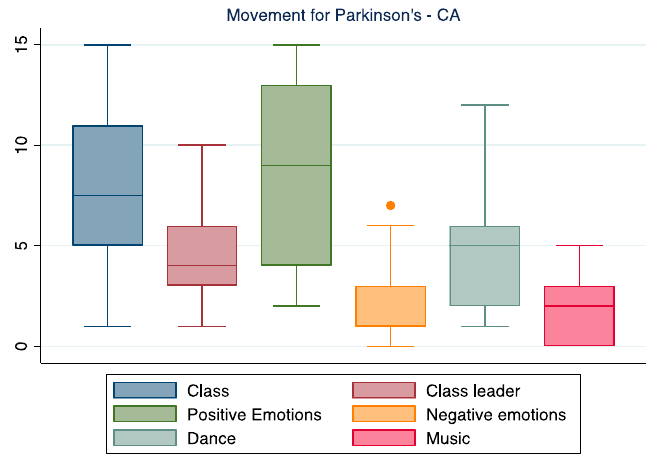
Figure 5. The focus on Movement for Parkinson’s. In the boxplot, the central horizontal line indicates the median, the other two lines indicate the first (lower line) and third (higher line) quartiles, the whiskers indicate the minimum and maximum values, and the dots indicate outliers.